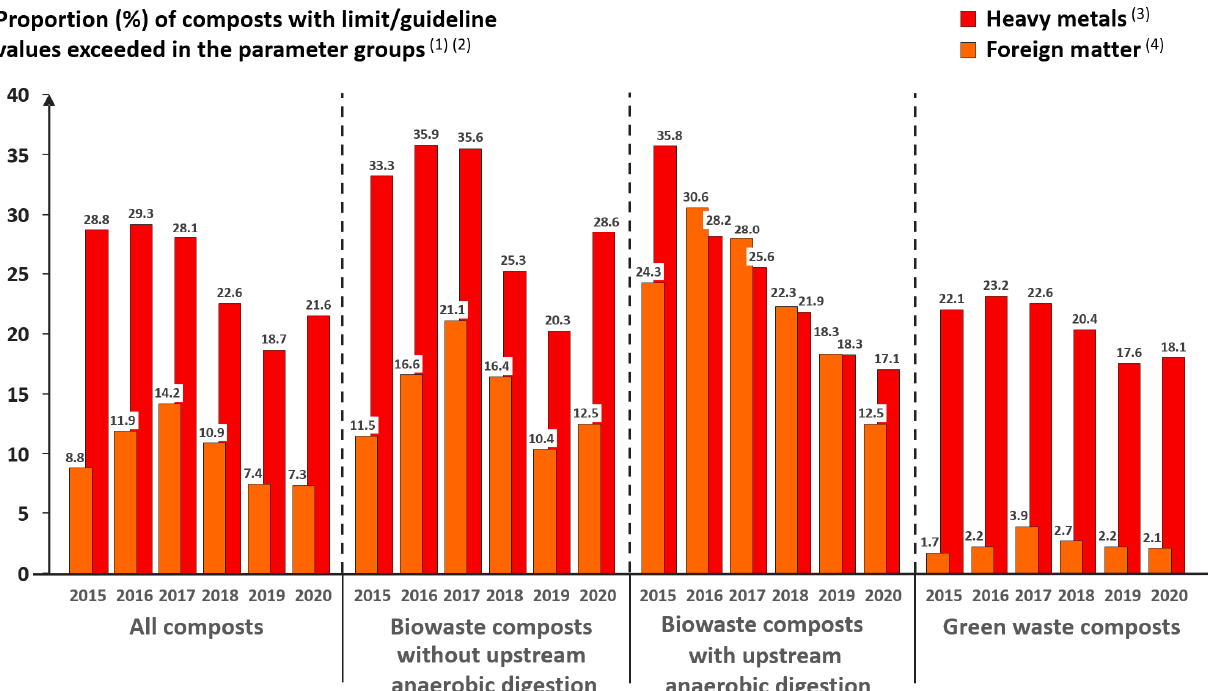
Figure 5. Influence of the parameter groups “heavy metals” and “foreign matter” on the proportion of biowaste and green waste composts not suitable for organic farming (composts according to RAL-GZ 251 Compost of BGK in Germany in 2015–2020) (1) (3) (4) . (1) Limit values ( ≤ ) according to EU-ÖkoV—EU Regulations on organic farming (Regulation (EC) No. 889/2008, Annex 1 resp. 2021/1165, Annex 2; guideline values ( ≤ ) according to Bioland/Naturland guidelines (5/2014 to 3/2020). (2) Proportion of composts with limit/guideline values exceeded in the respective parameter group = Proportion of composts unsuitable for organic farming in % of all composts of the RAL quality assurance 251 compost of BGK (n = 3272 in 2015, n = 3345 in 2016, n = 3361 in 2017, n = 3536 in 2018, n = 3677 in 2019, n = 3841 in 2020 (BGK 2016–2021). (3) Parameter group heavy metals: Pb, Cd, Hg, Cr, Ni, Zn, Cu. (4) Parameter group foreign matter: (a) gravimetrically measured foreign matter content (all foreign matter, dry weight), (b) surface index (standardized area measurement of foreign matter, usually light film plastics and composites with a high surface area are recorded, which only make up a small proportion in the gravimetric measurement but are particularly conspicuous